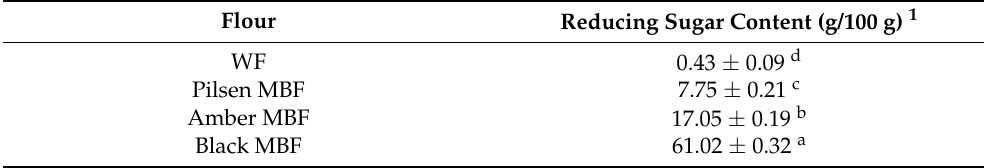
Table 1. Content of reducing sugars in wheat flour (WF) and malted barley flours (MBF).